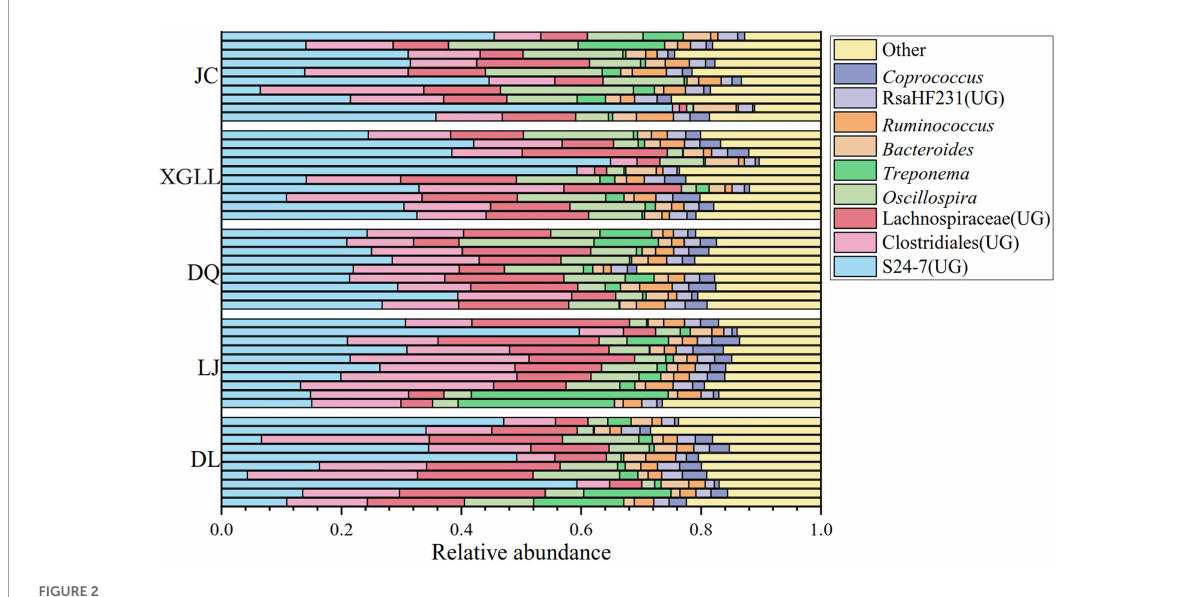
FIGURE2 Microbial genera level microbial composition in Eothenomys miletus.